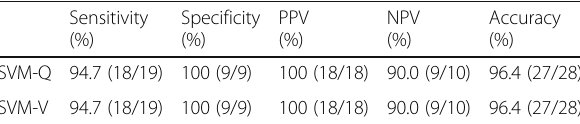
Table 3 Sensitivity, specificity, PPV, NPV, and accuracy of the SVM-Q and